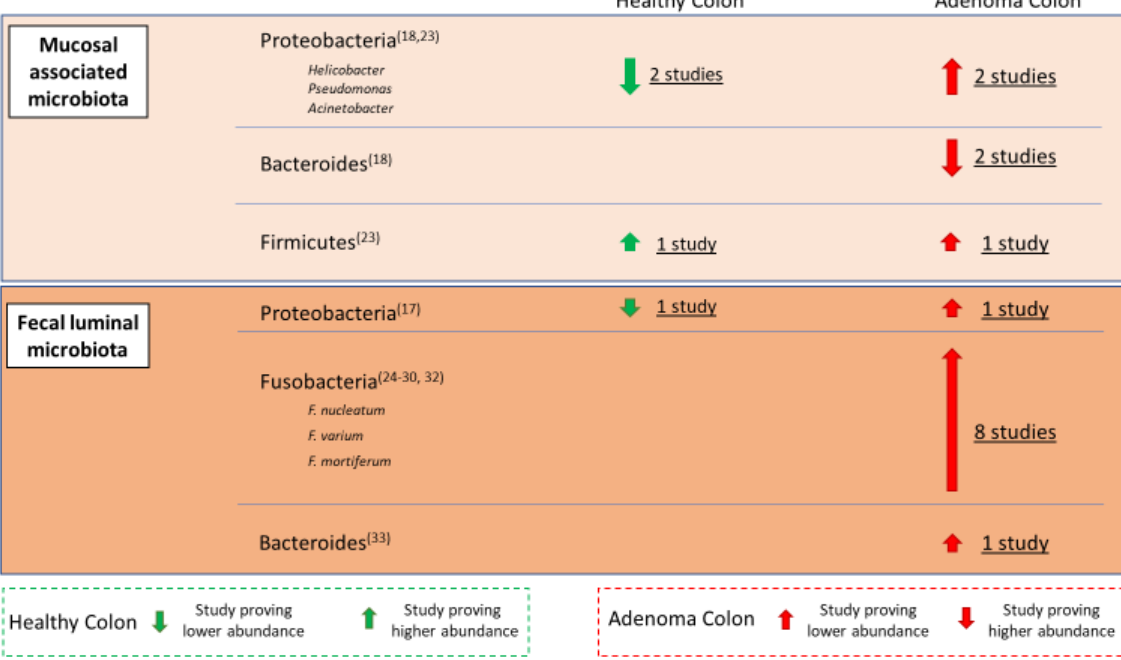
Figure 2. Distribution of main bacterial families of human microbiota in the physiological condition and in adenoma pa- tients (the thickness of the arrows is linked to the strength of the scientific evidence drawn from the literature).